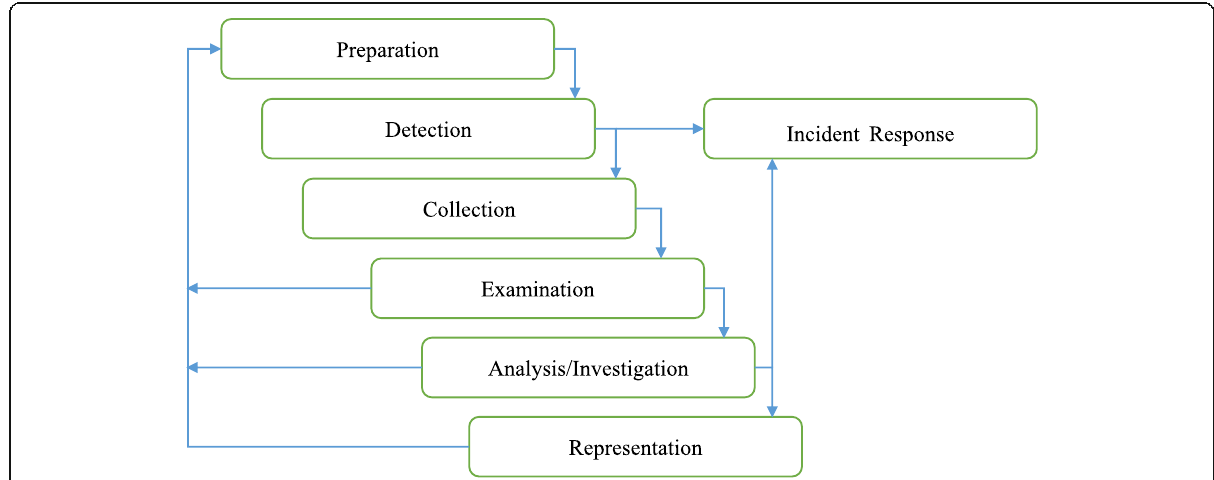
Fig. 5 A process model for memory